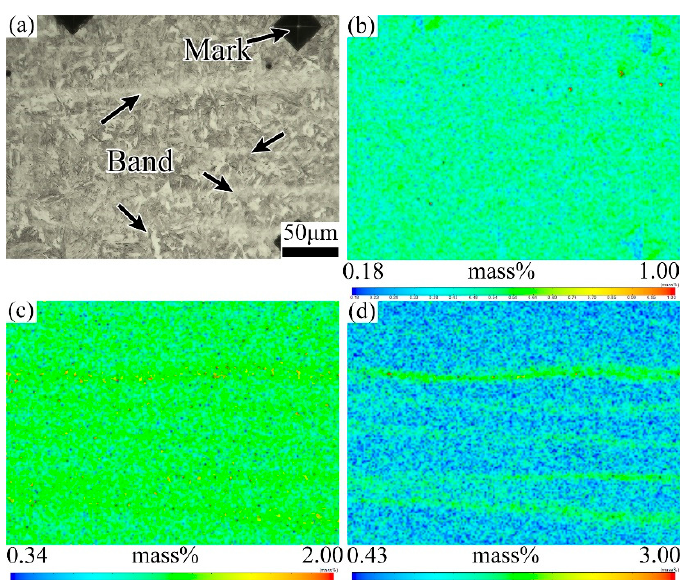
Figure 7. EPMA analysis of map scanning on the banded structure of as-quenching simple. ( a ) Optical micrograph of the banded structure; ( b ) EPMA maps of element C; ( c ) EPMA maps of Cr; ( d ) EPMA maps of Mo.